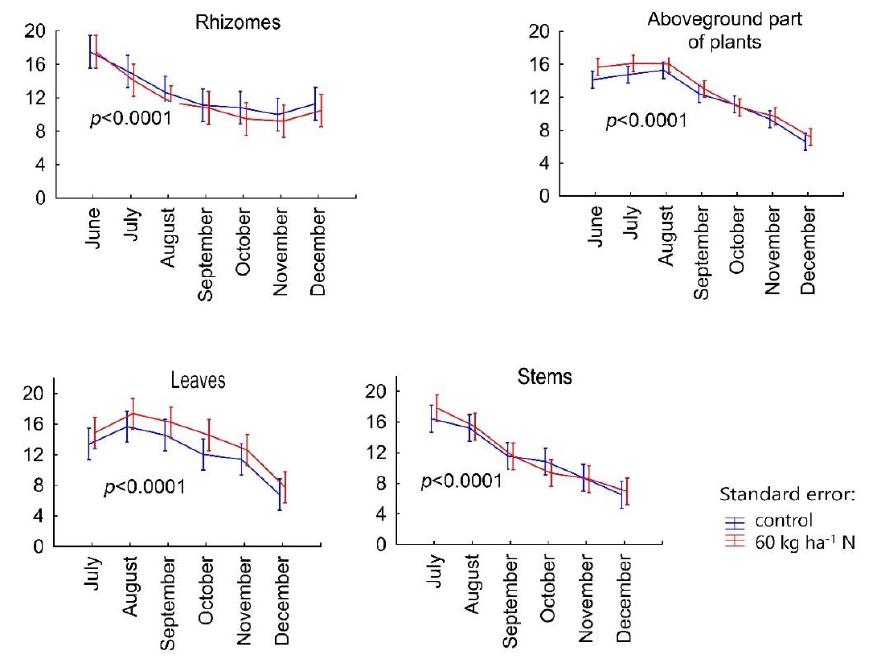
Figure 4. Potassium content in examined part of miscanthus (g kg −1 ).